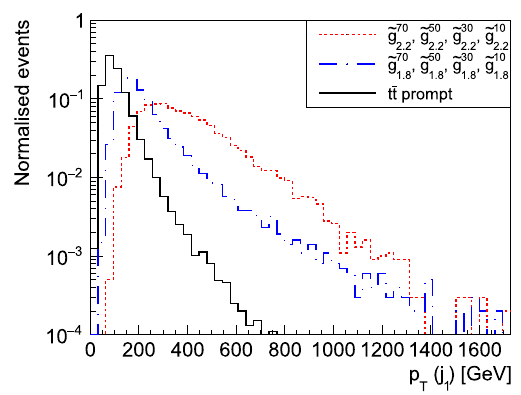
Fig. 69 Transverse momentum of the leading jet in the gluino ˜ g case